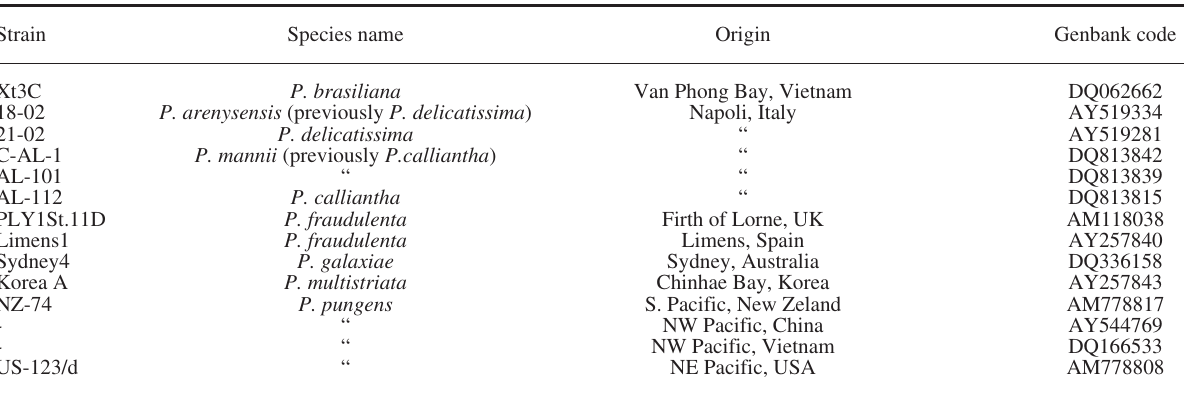
Table 3. – 5.8S rDNA gene and ITS region sequences of different Pseudo-nitzschia strains obtained from GenBank used in the phy-